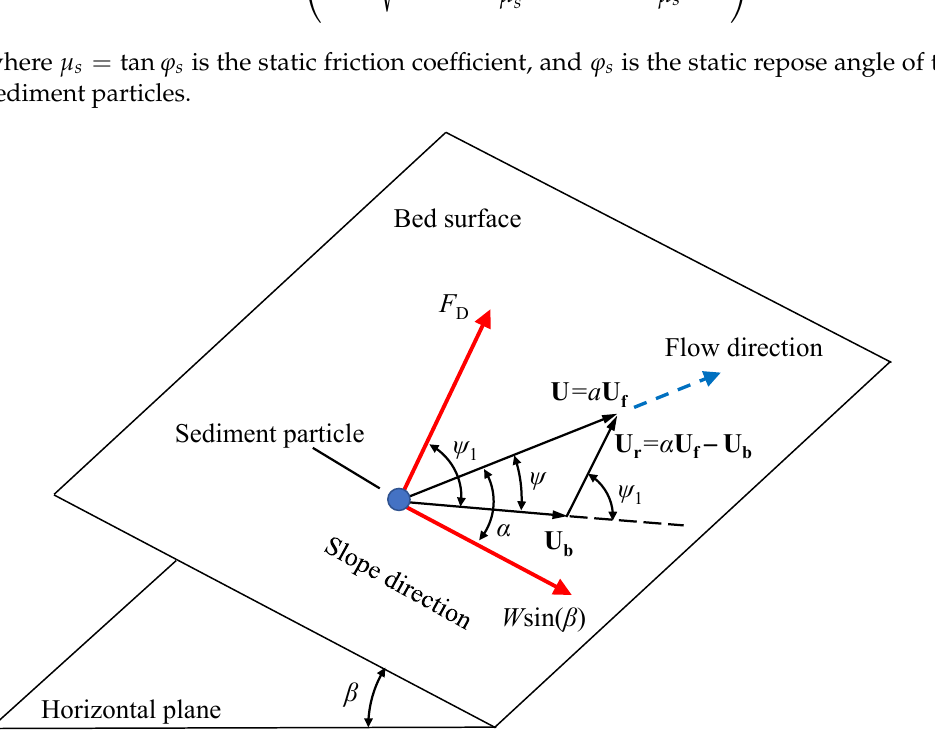
Figure 2. A sketch of sediment transport on a slope bed. Sediment particles move in the water in the forms of bed load and suspended load once the threshold is exceeded. Bed load includes sediment particles that roll, slide or saltate along the seabed surface, and the suspended load includes the sediment particles that are entrained off the bed and suspended in water volume. In numerical simulations, bed load and suspended load are artificially divided at a reference level above the seabed, which is defined as z a . The sediment particles above and below this level are treated as suspended load and bed load, represented by q s and q b , respectively. It should be noted that there is not a clearly defined boundary between bed load and suspended load in reality. The reference level is used mainly to facilitate numerical analysis.